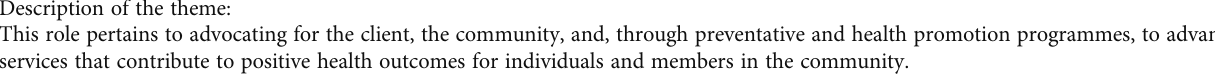
Table 5: Theme 4: role as a health